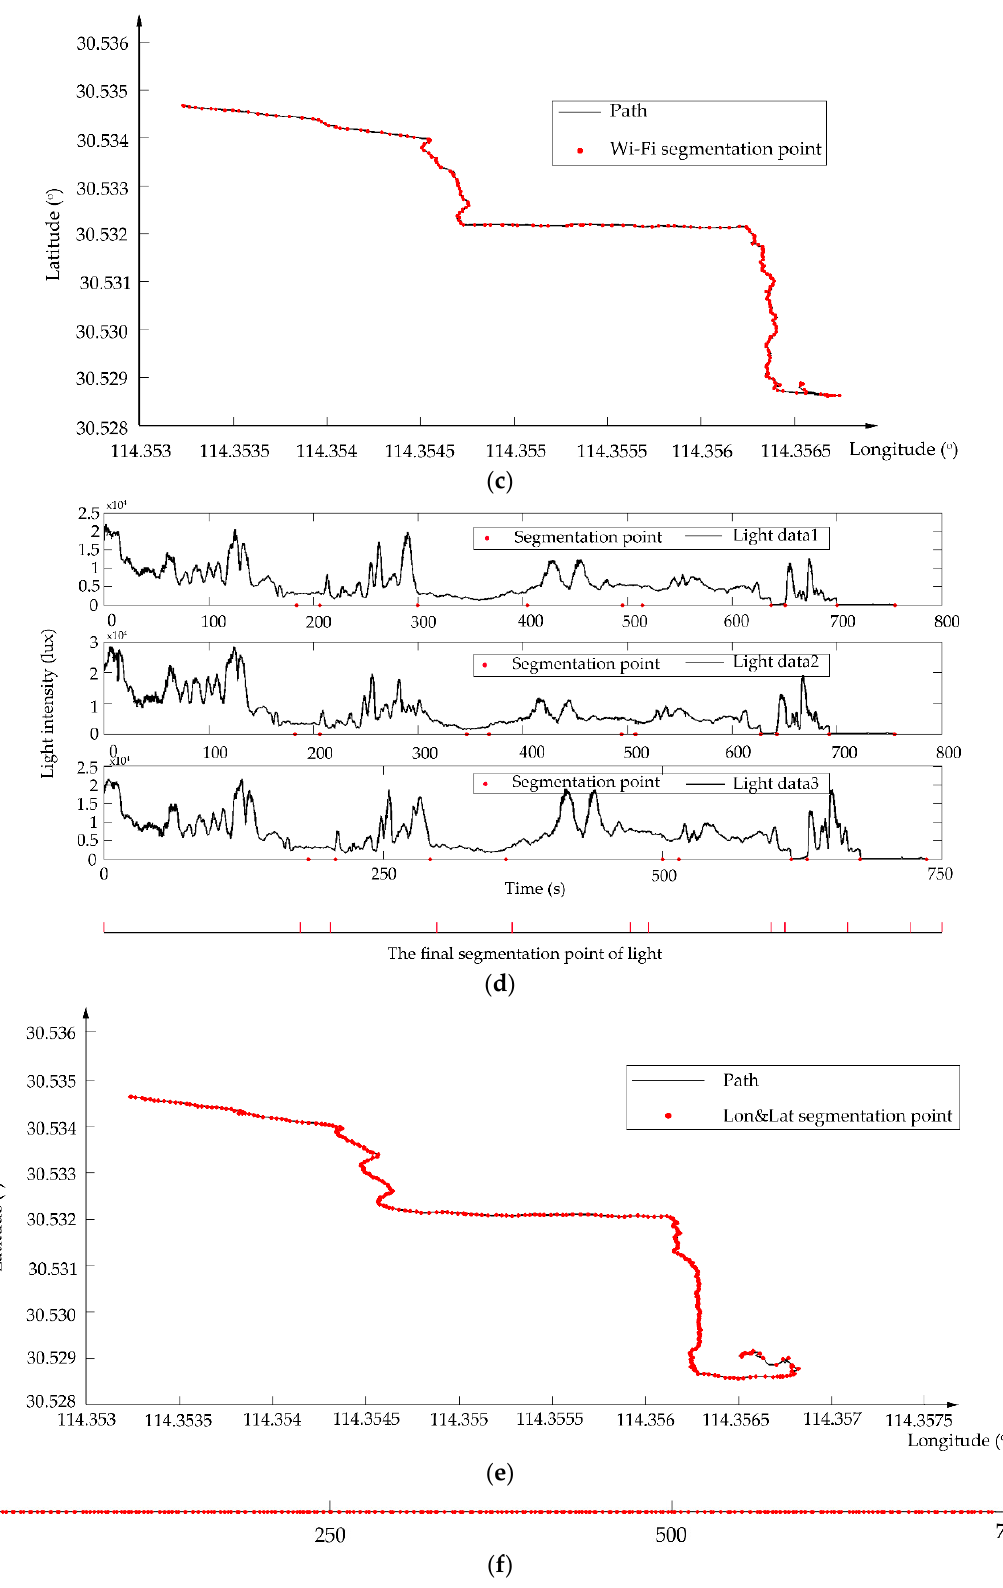
Figure 12. Sensor segmentation results and frame of discernment: ( a ) gyroscope; ( b ) magnetometer; ( c ) Wi-Fi; ( d ) light; ( e ) longitude and latitude; ( f ) frame of discernment.